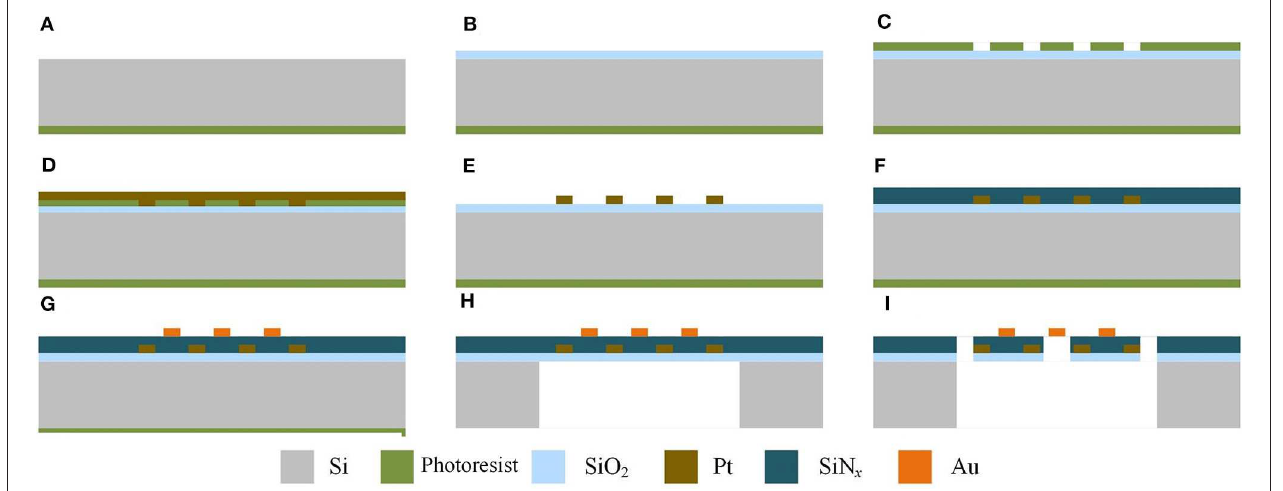
FIGURE 2 | Steps of processing of the planar gas sensor in sectional view. (A) The productive layer of Si base layer productive. (B) SiO 2 insulting layer is produced by thermal oxidation. (C) Photolithographing on the heating electrode. (D) Sputter the Pt electrode. (E) Remove the metal-attached photoresist by stripping. (F) Deposition of SiN x isolation layer on the heating electrode. (G) Photolithography, sputtering and stripping of Au electrode. (H) Corrosion of Si base layer. (I) Etching of SiO 2 insulating layer and SiN x isolation